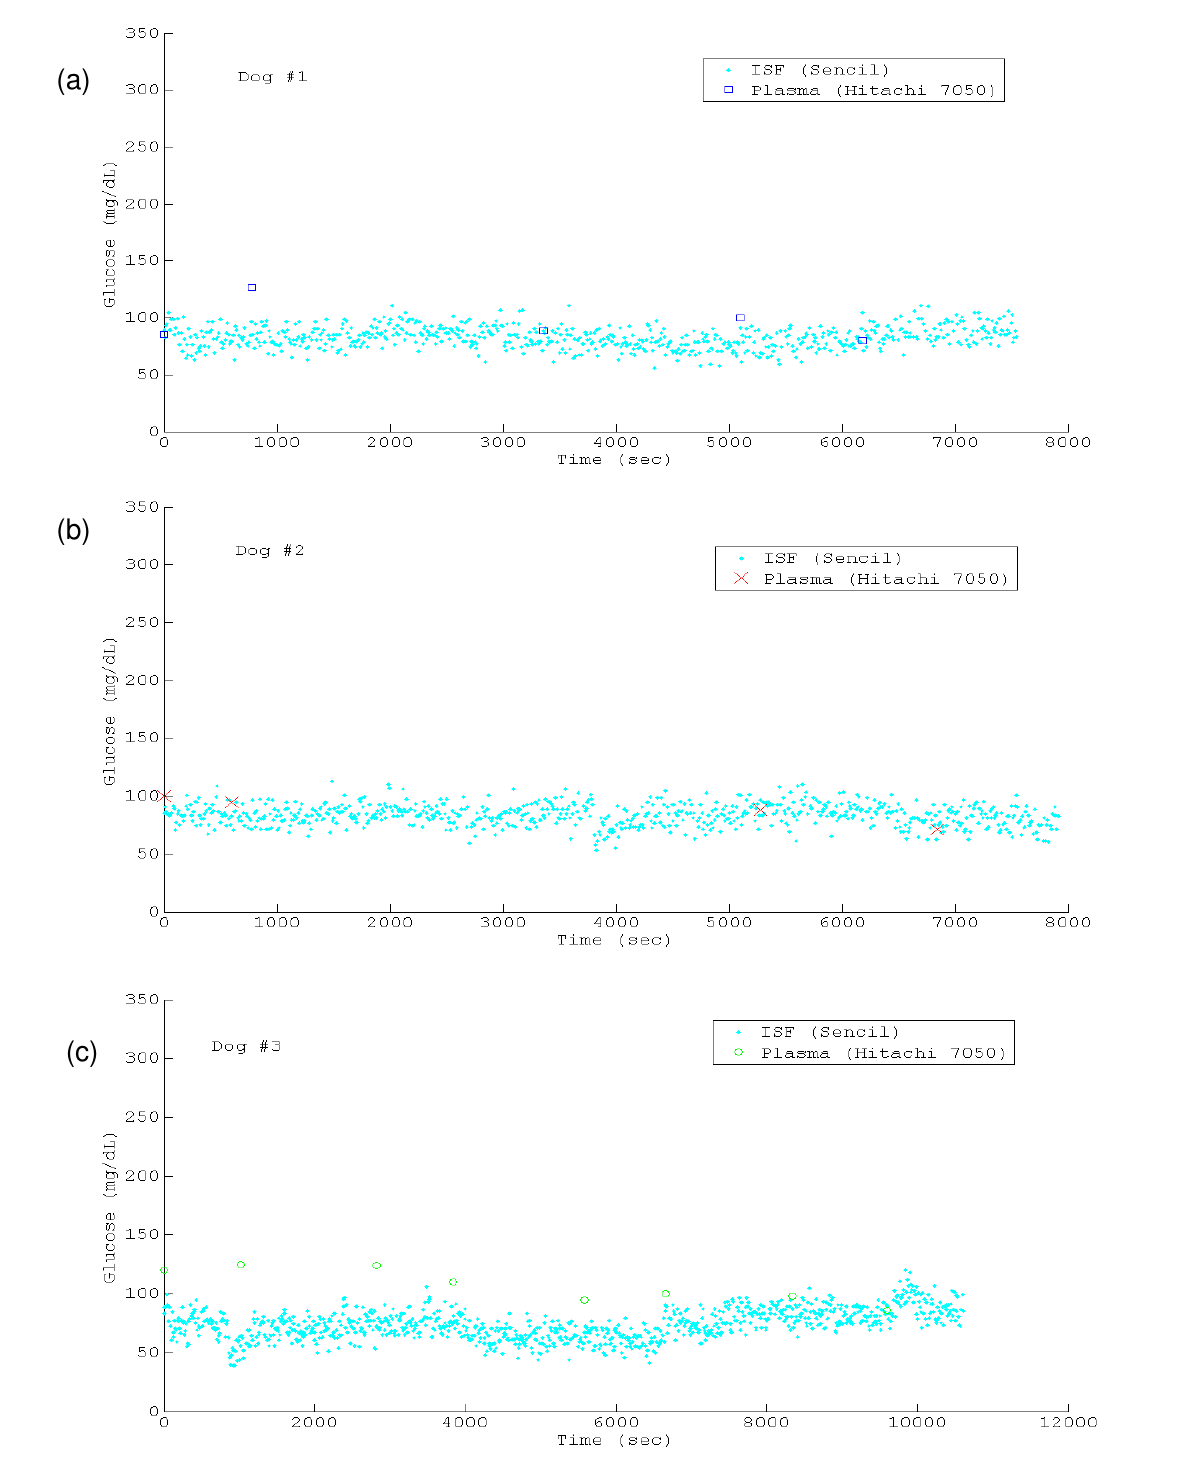
Figure 5. Profiles of the ISF reading from Sencil TM and plasma reference